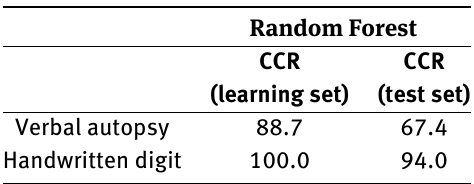
Table 4: Correct Classification Rate (CCR) obtained with Random Forest ( nodesize=1 and ntree=500 ). The training set includes τ = 63% individuals from the initial